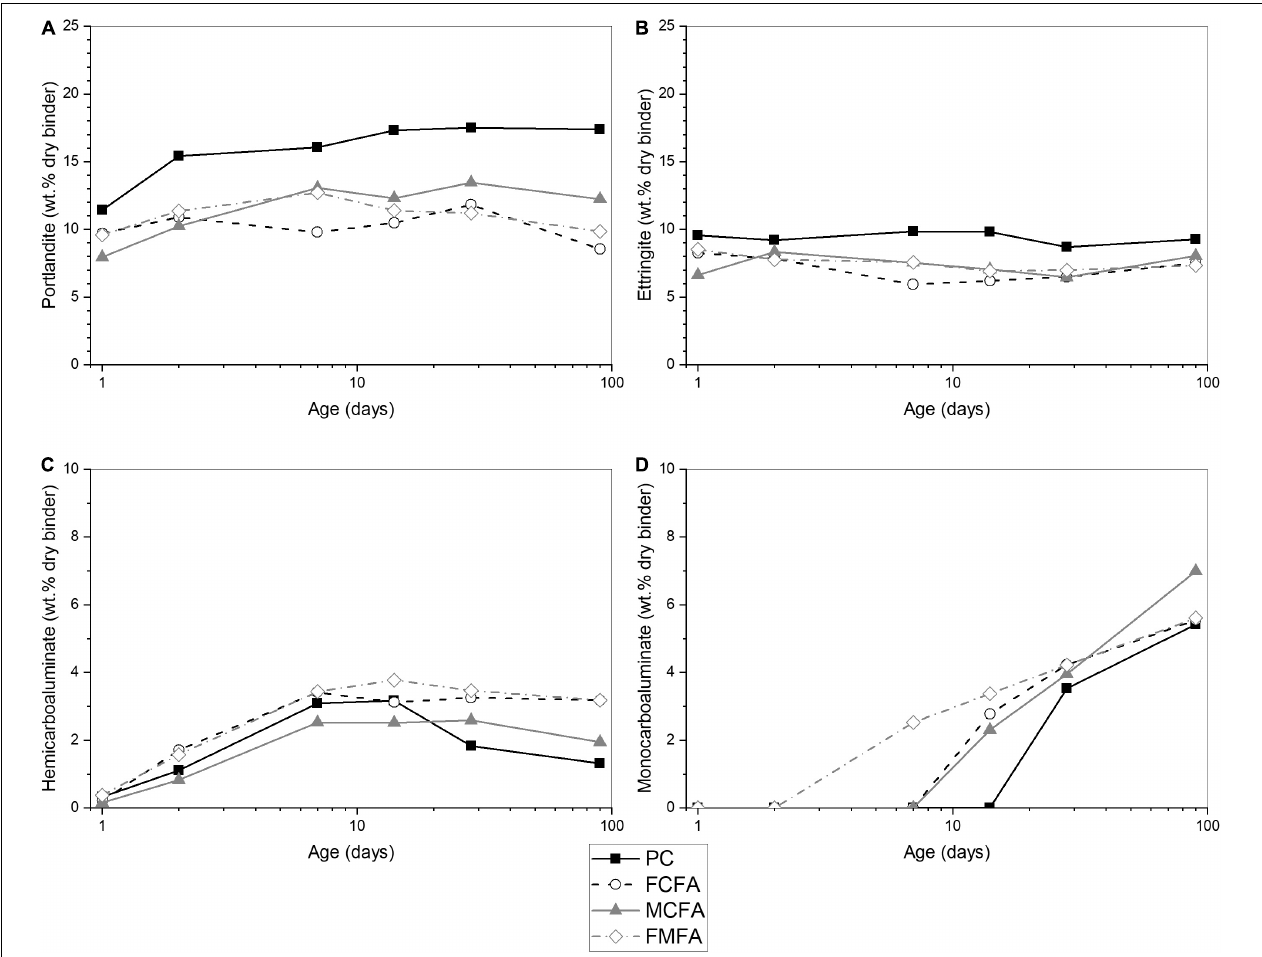
FIGURE 8 | XRD-Rietveld analysis results showing the formation of cement hydration products from 1 to 90 days of hydration for the fly ash blended cements and the reference Portland cement. (A) : portlandite, (B) : ettringite, (C) : hemicarboaluminate, (D) :